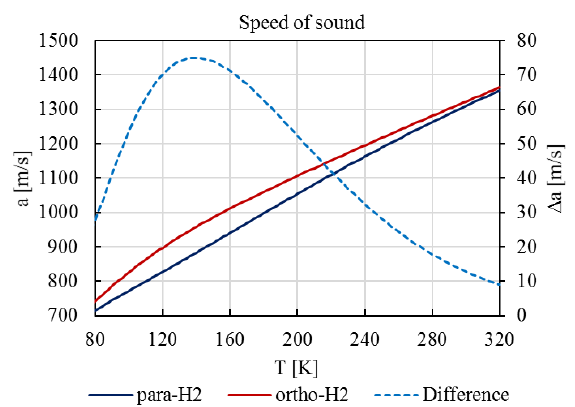
Figure 5. Speed of sound a of ortho-H 2 and para-H 2 and their difference Δ a vs. temperature